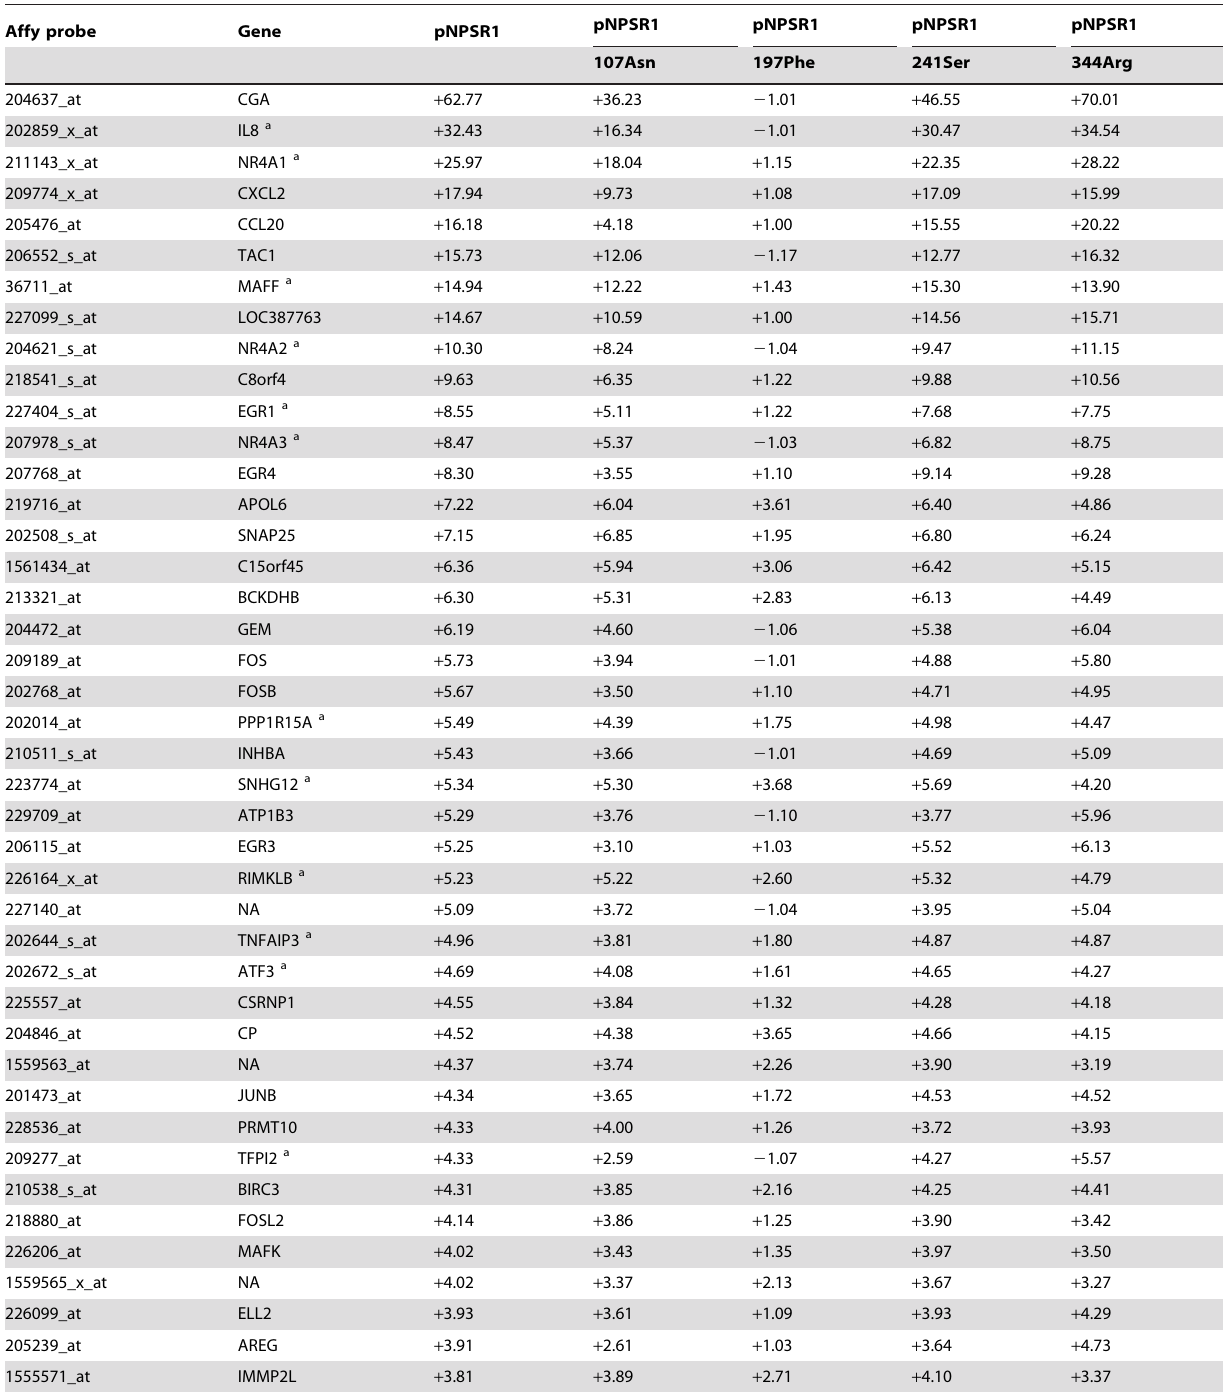
Table 1. Genes differentially expressed upon NPS